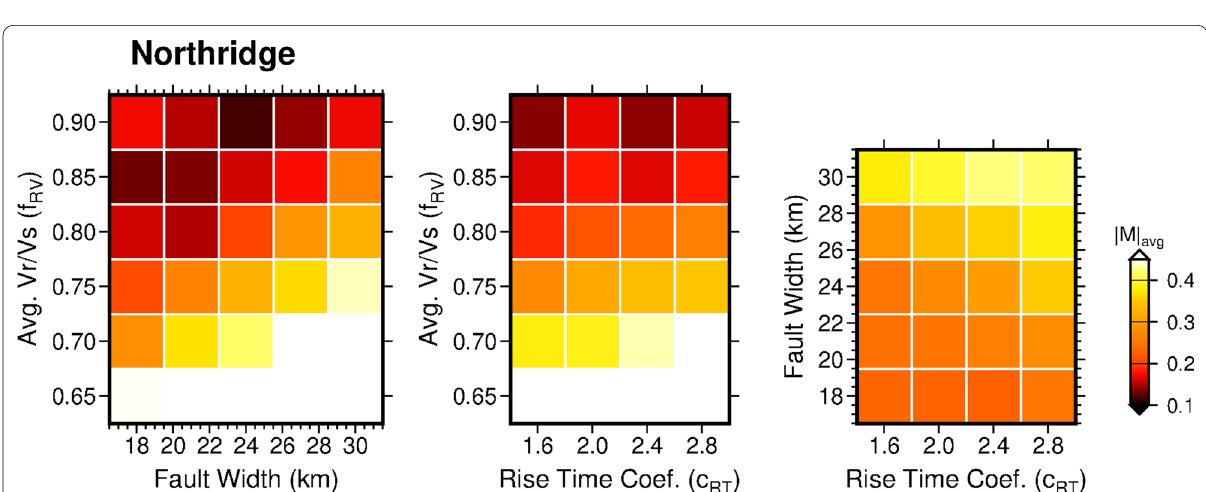
Fig. 6 Color shading shows the trend of the average absolute misfit for discrete pairs of kinematic rupture parameters: f RV vs. fault width (left panel), f RV vs. c RT (middle panel), and fault width vs. c RT (right panel). The value plotted for each individual parameter pair is determined by averaging the | M | avg values for the subset of ruptures sharing the particular parameter